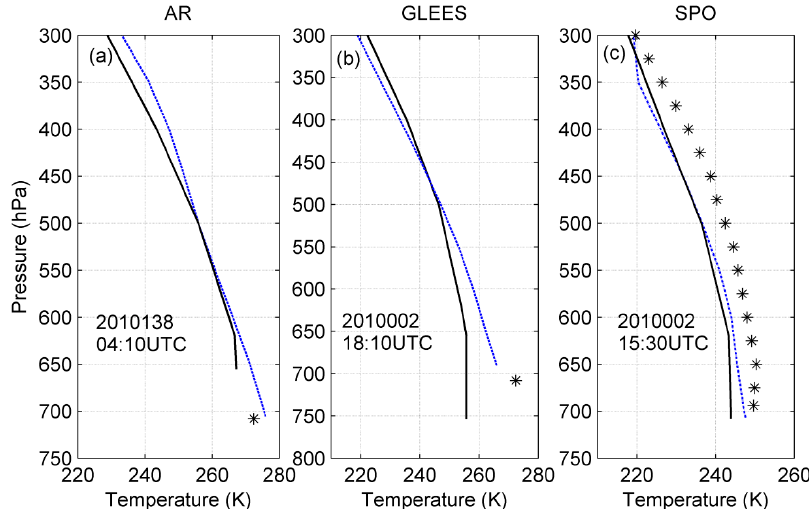
Figure 12. Vertical distribution of air temperatures from the National Centers for Environmental Prediction (NCEP) and MOD07 profiles at sites Arou (AR), US-GLE Wyoming (GLEES), and South Pole (SPO). The solid line, dashed line, and asterisk represent MODIS, NCEP, and field-measured data, respectively.